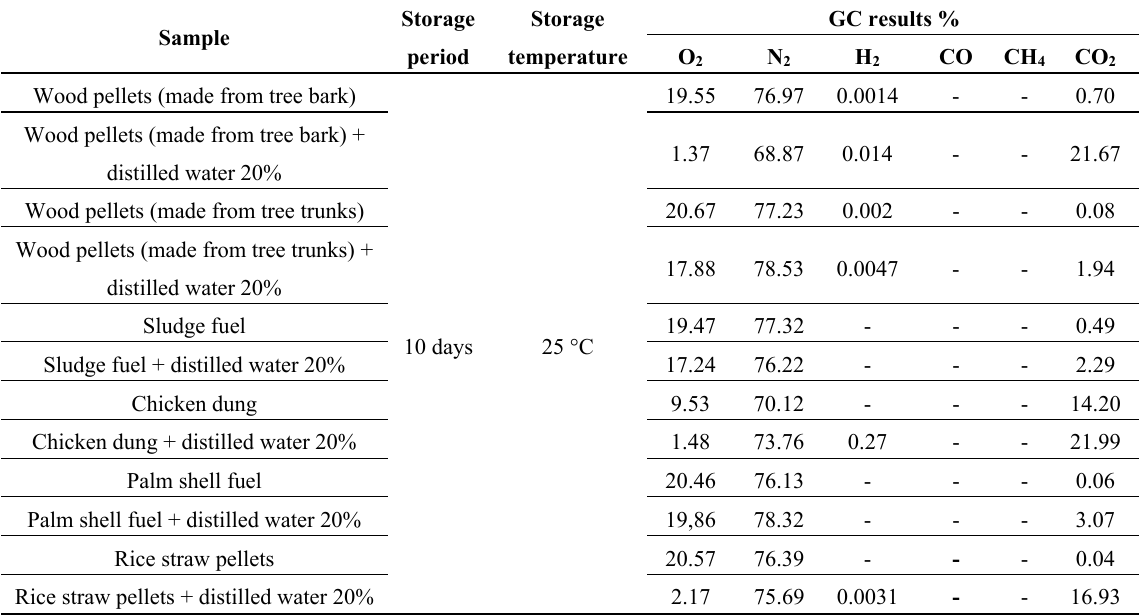
Table 3. GC results for untreated samples of various biomass fuels (25 °C). Storage Sample period